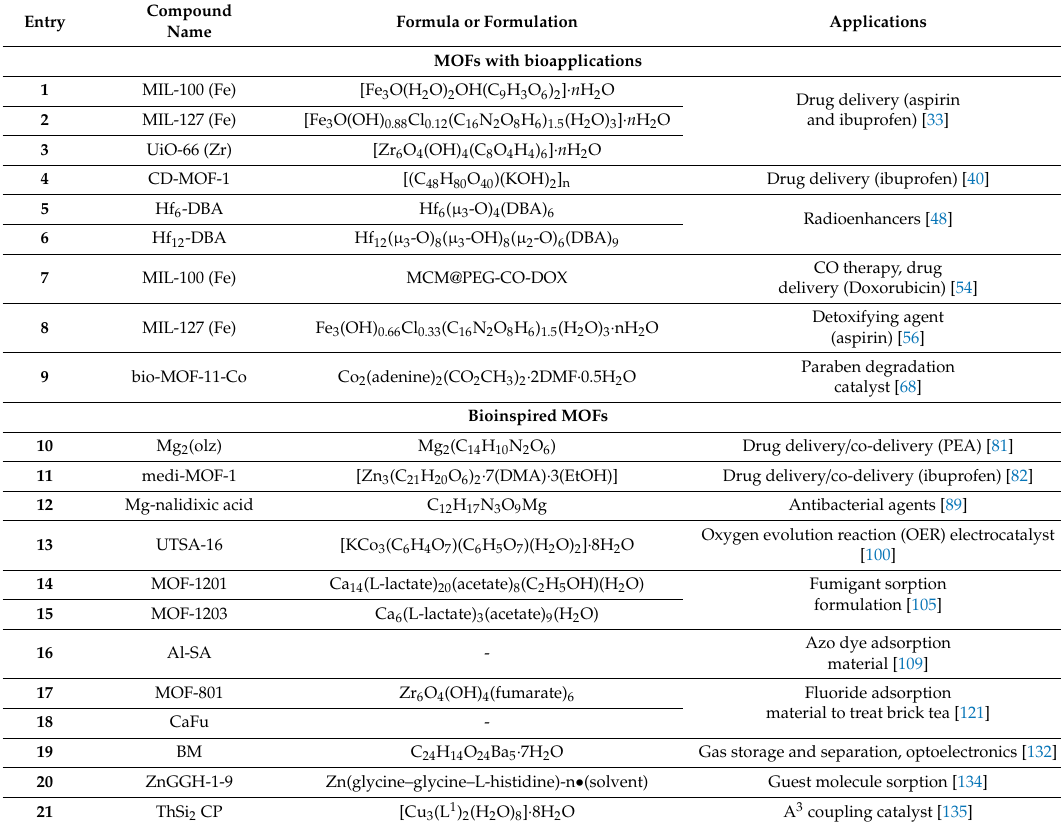
Table 6. A summary of the MOFs discussed, with bioapplications and with bioinspired